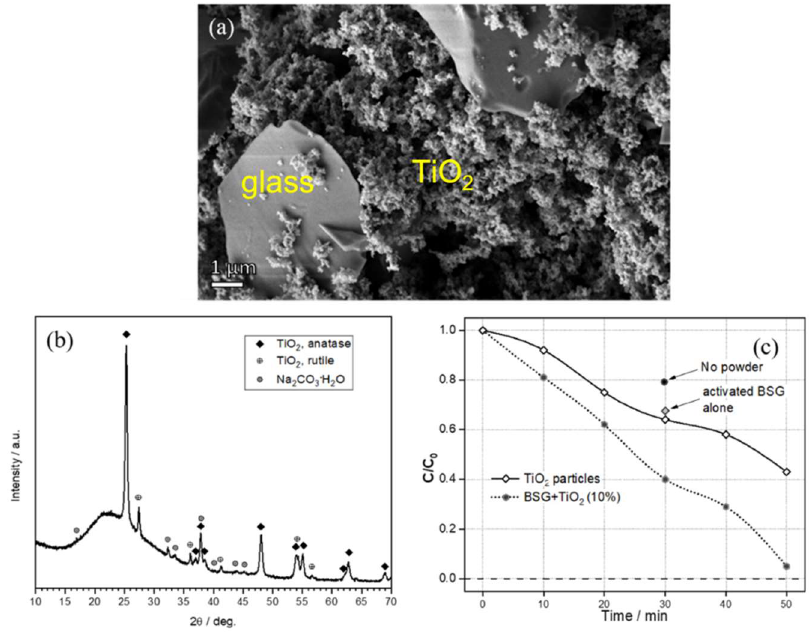
Figure 7. ( a ) Detail of glass/TiO 2 composite granule; ( b ) diffraction analysis of hardened glass/TiO 2 suspension; ( c ) evolution of relative concentration with increasing UV exposition time operating with TiO 2 photocatalyst.